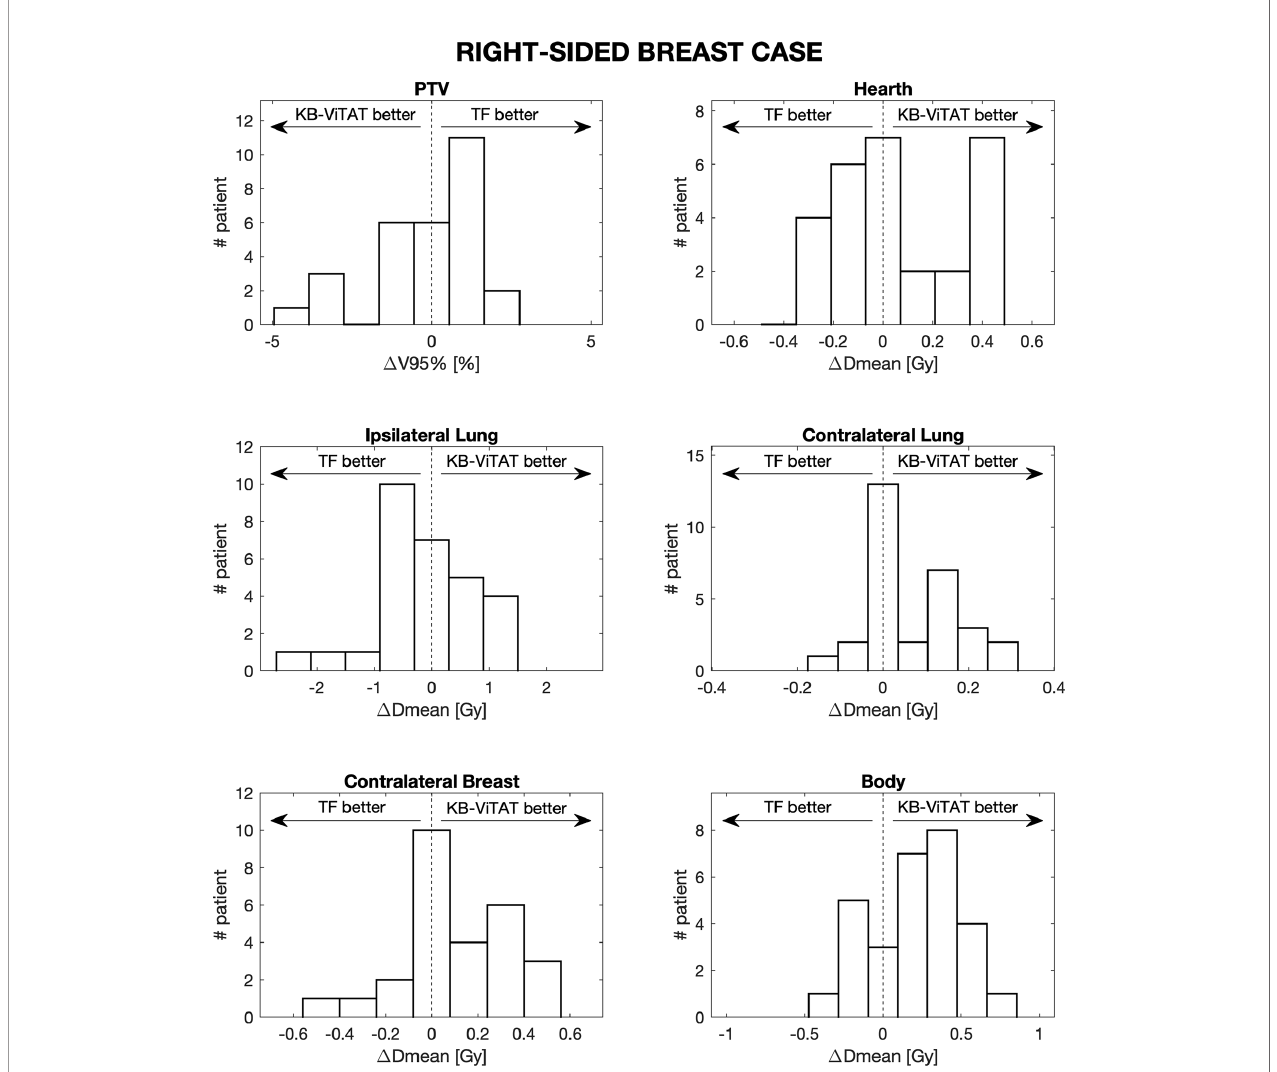
FIGURE 4 | Population histograms of the differences between the clinical tangential fi eld TF and automated re-optimized KB-ViTAT plans for the investigated dosimetric parameters for right-sided breast case, showing the V95% parameter for PTV and mean doses for